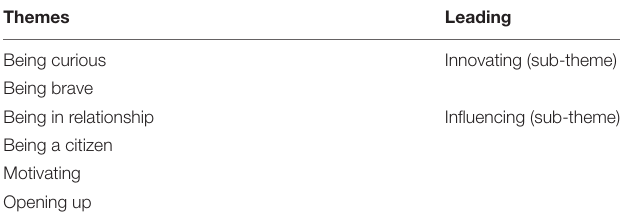
TABLE 2 | Relationships between